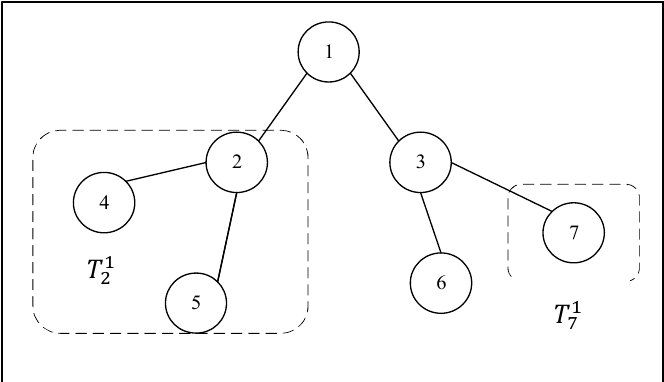
Figure 2. Illustration the definition of subtree variable T v